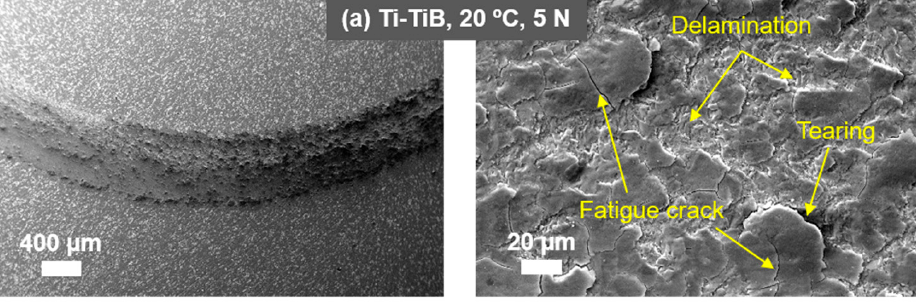
Figure 6. SEM images of composite surfaces with different magnification taken after sliding test. The test conditions are indicated in the figure. At 800 °C, an oxidative wear has demonstrated a noticeable effect. The frictional sur- face was dominated by an even oxide layer. In general, the wear at this stage is mainly conditioned by the fragmentation of oxide scales; the direct contact between the alumina ball and the composite surface is limited. The XRD pattern in Figure 7 details the phases on the surface demonstrating the formation of rutile and the presence of boric acid.